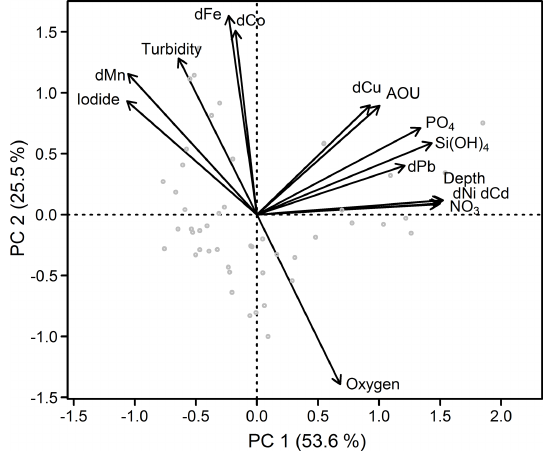
Figure 4. Principal component analysis of the Mauritanian shelf data set. Principal component loadings for each variable are indi- cated by black vectors. Component scores of each sample are indi- cated as gray circles. Loadings and scores have been scaled sym- metrically by square root of the